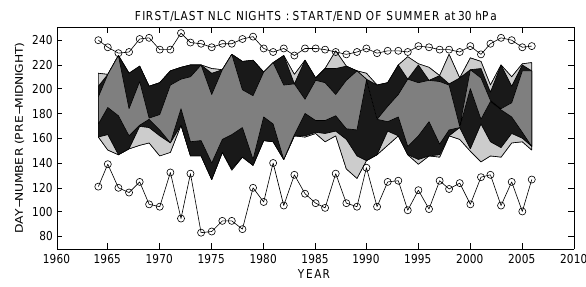
Fig. 2. Comparison of the NLC season (gray areas) with the start and end of summer in the stratosphere (circles/solid lines), de- fined as the period when the zonal-mean, zonal wind at 60 ◦ N, 30hPa was consistently directed westward, according to ERA-40 (1664–August 2002) and operational (September 2002–2006) anal- yses from ECMWF. The shades of grey denote: all NLC reported (light gray), nights where moderate or stronger NLC were reported (black), and nights when bright or very bright displays were re- ported (dark gray). The gray/black areas are